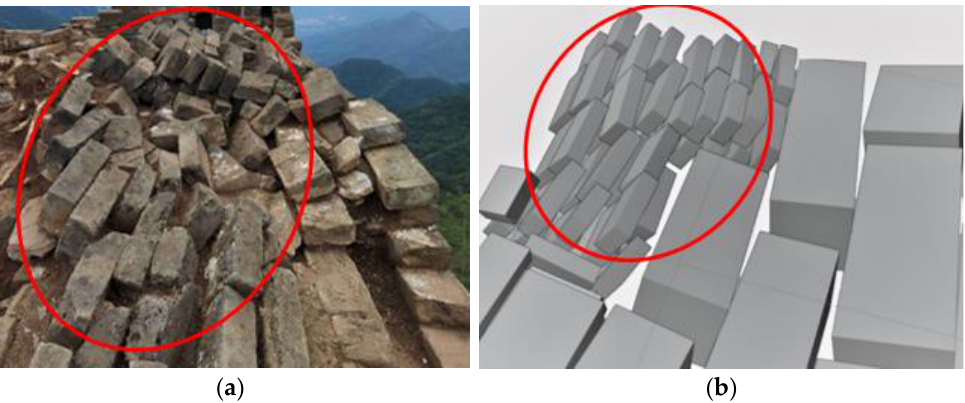
Figure 18. Comparison of parapet wall collapse: ( a ) Site picture; ( b ) Simulation.